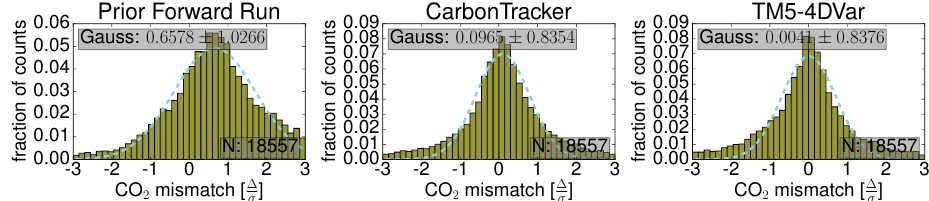
Figure 4. Histograms of the mismatch between measured and modeled CO 2 concentrations for all non-assimilated samples using prior fluxes, CarbonTracker optimized fluxes and TM5-4DVar optimized fluxes. The histograms show residuals for one year (3 April 2009 to 2 April 2010) which are normalized by the estimated representativeness error. The line on top of the histograms is a fit of a Gauss function to the histogram. The parameters in the top left show the bias and standard deviation of the histogram. The bottom right shows the number of measurements which were accumulated into the histogram.